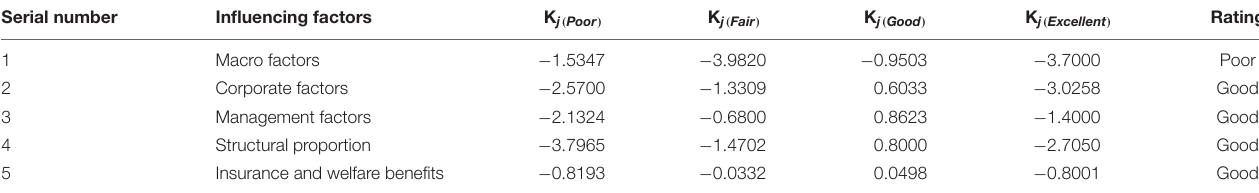
TABLE 7 | Correlation degree of influence indicators (first-level indicators).